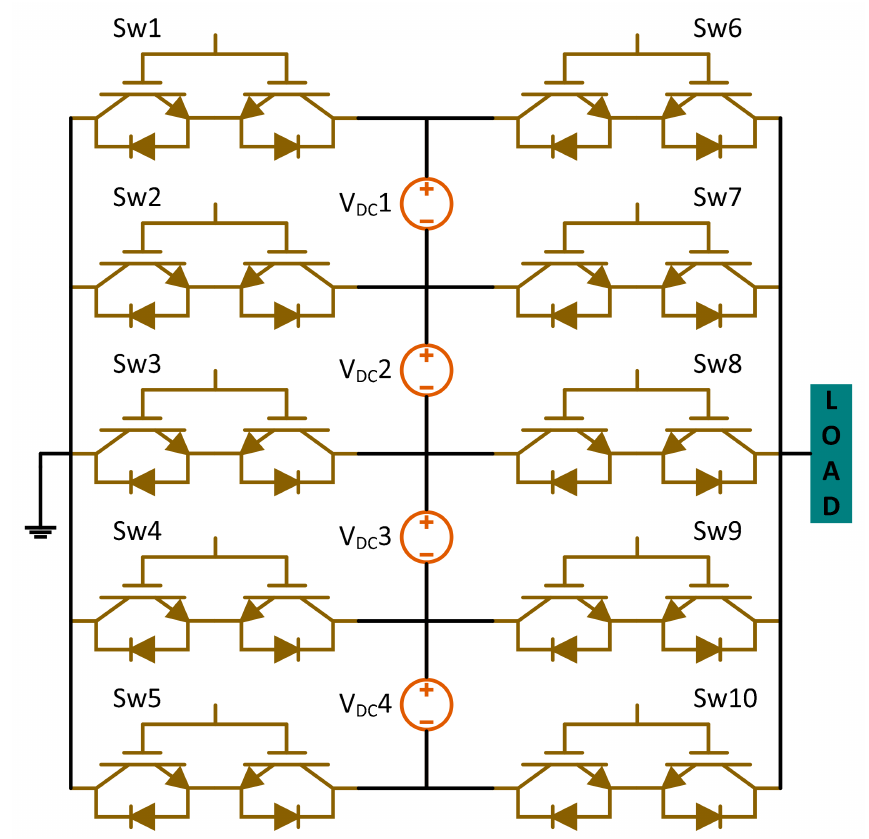
Figure 23. Topology of cascaded bipolar switched cells multilevel